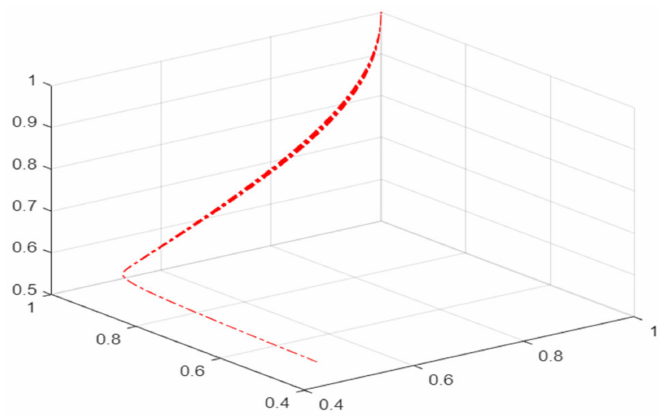
Figure 9. Sensitivity analysis of parameter F2.